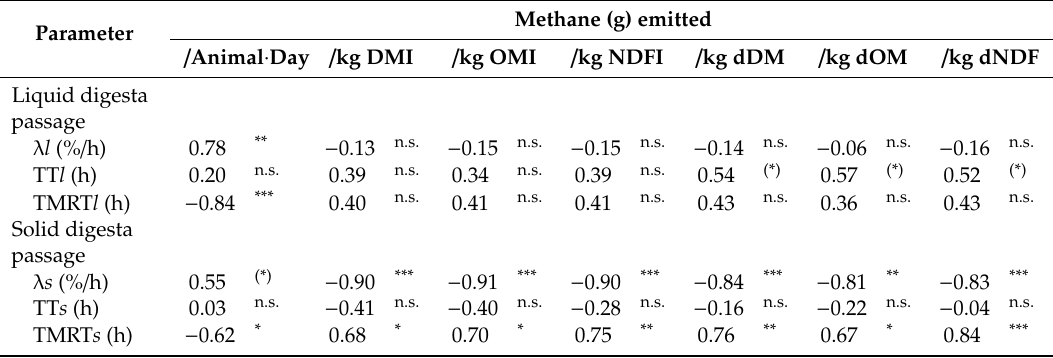
Table 7. Spearman correlation coe ffi cients (r s ) and significance levels 1 of the relationship between liquid ( l ) and solid ( s ) digesta passage parameters and the emission of methane in heifers fed with roughage alone or supplemented with sweet potato vine silage or urea-molasses